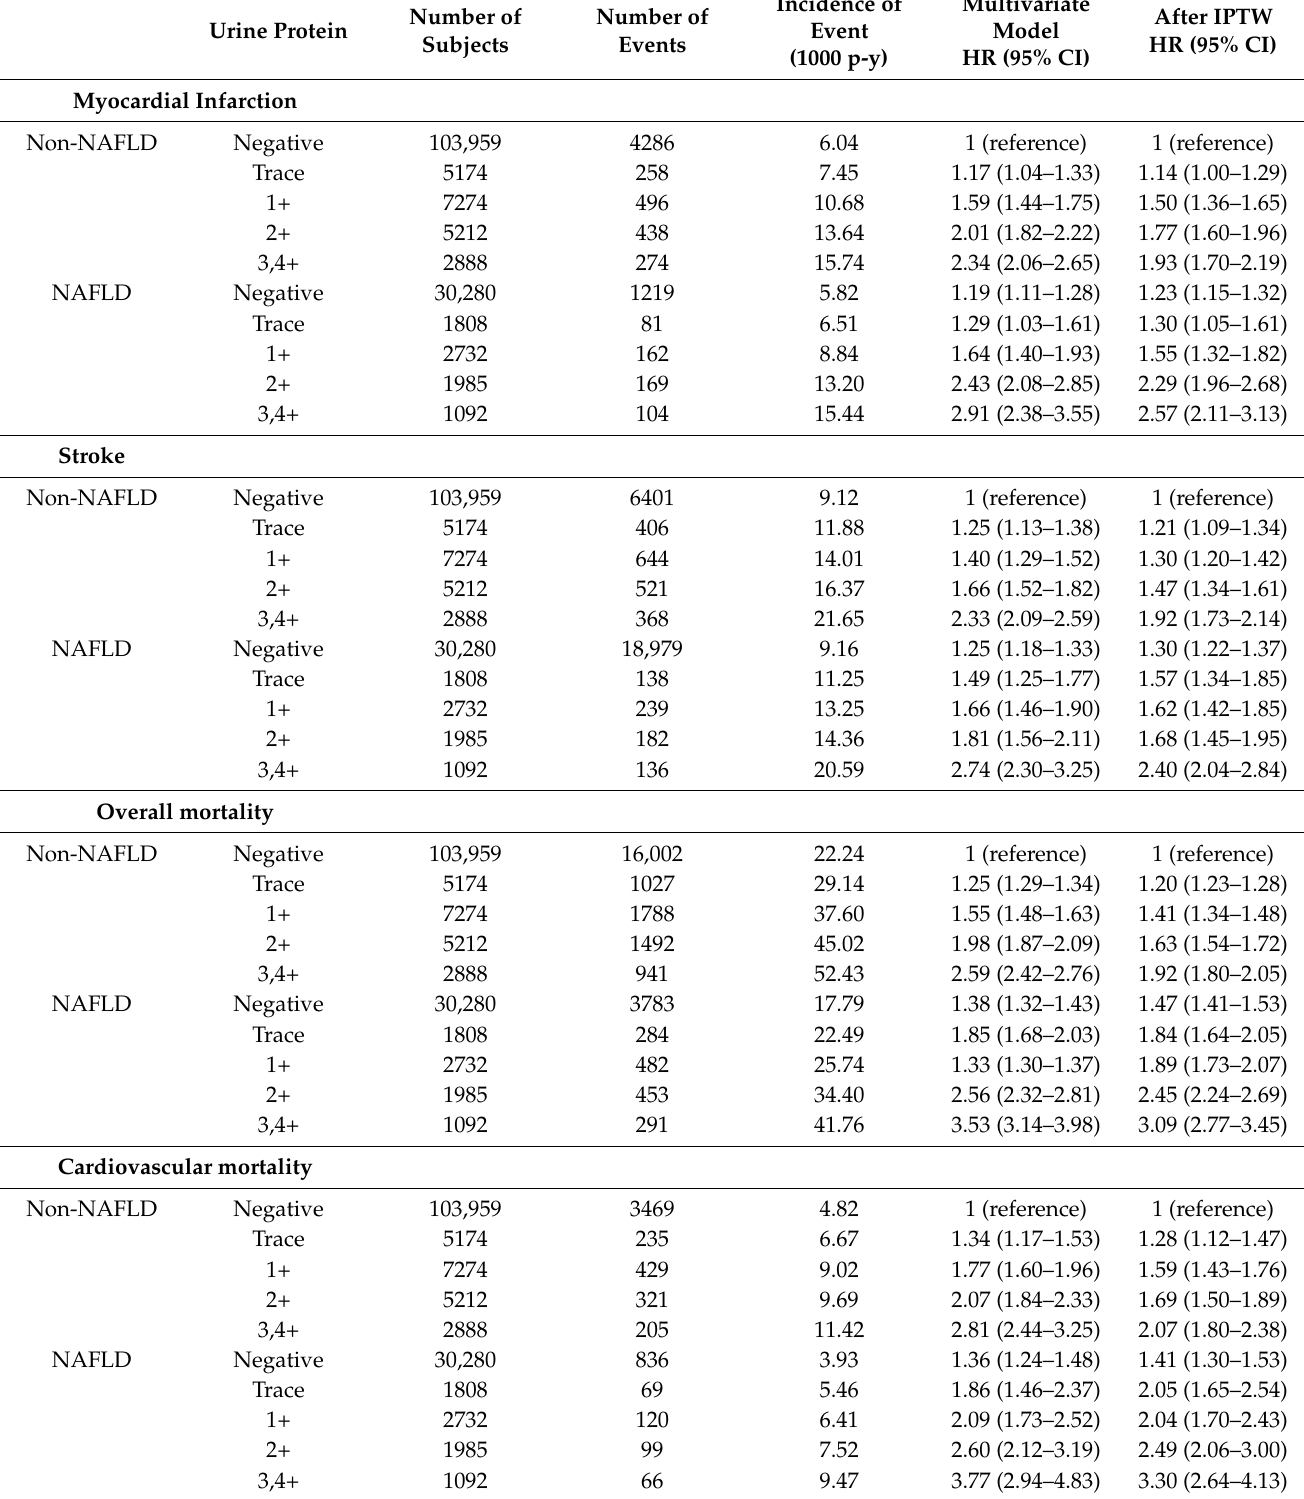
Table 4. Risk of cardiovascular events in subjects with CKD according to